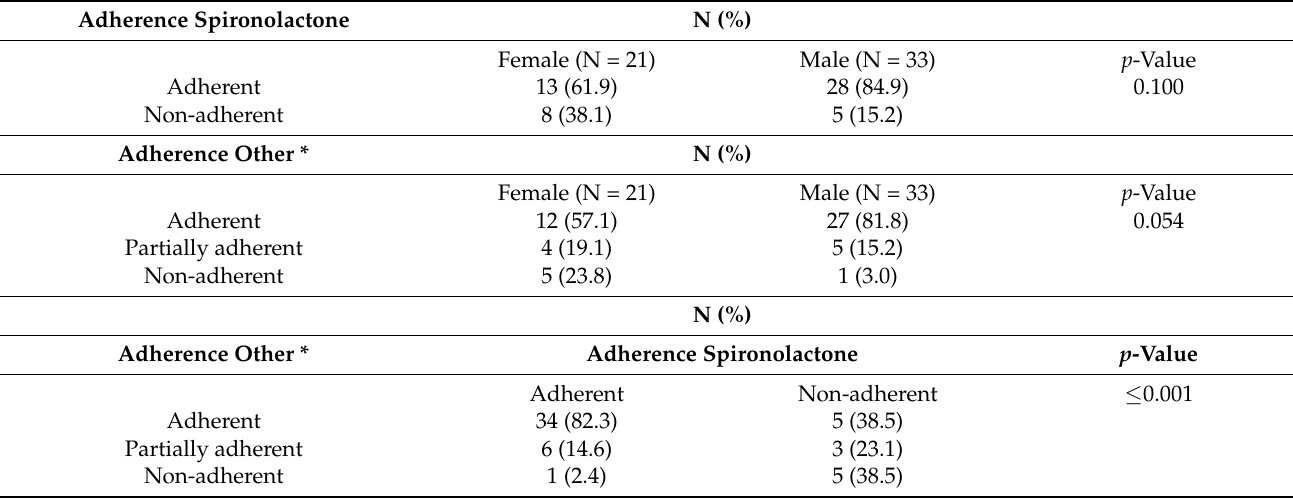
Table 4. Adherence of spironolactone and other drugs between